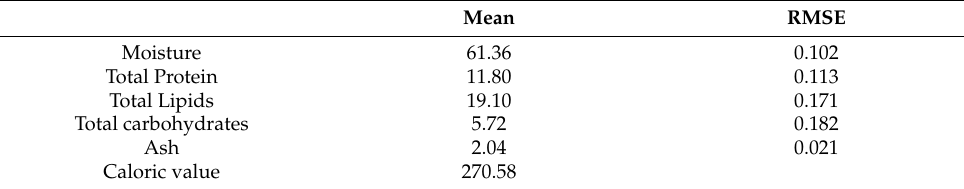
Table 3. Proximate composition (g/100 g) and caloric value (kcal/100 g) of salmon p â t é .